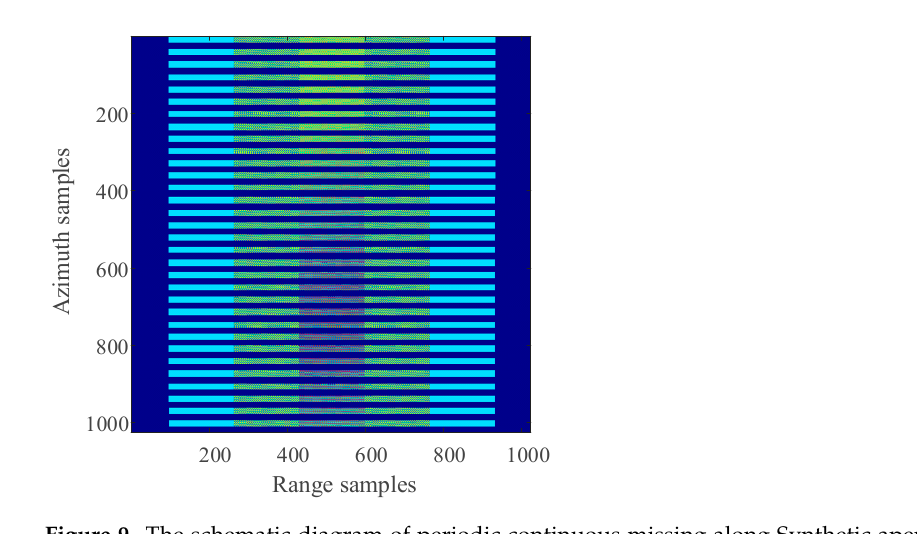
Figure 9. The schematic diagram of periodic continuous missing along Synthetic aperture radar (SAR) azimuth.